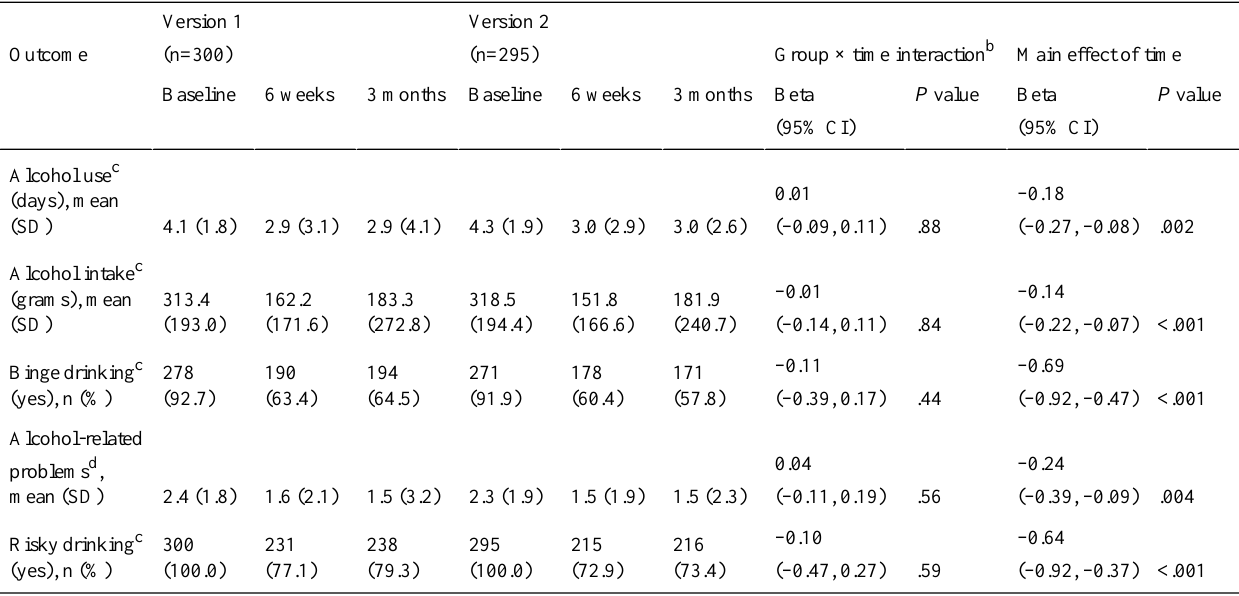
Table 3. Effectiveness results a of study primary